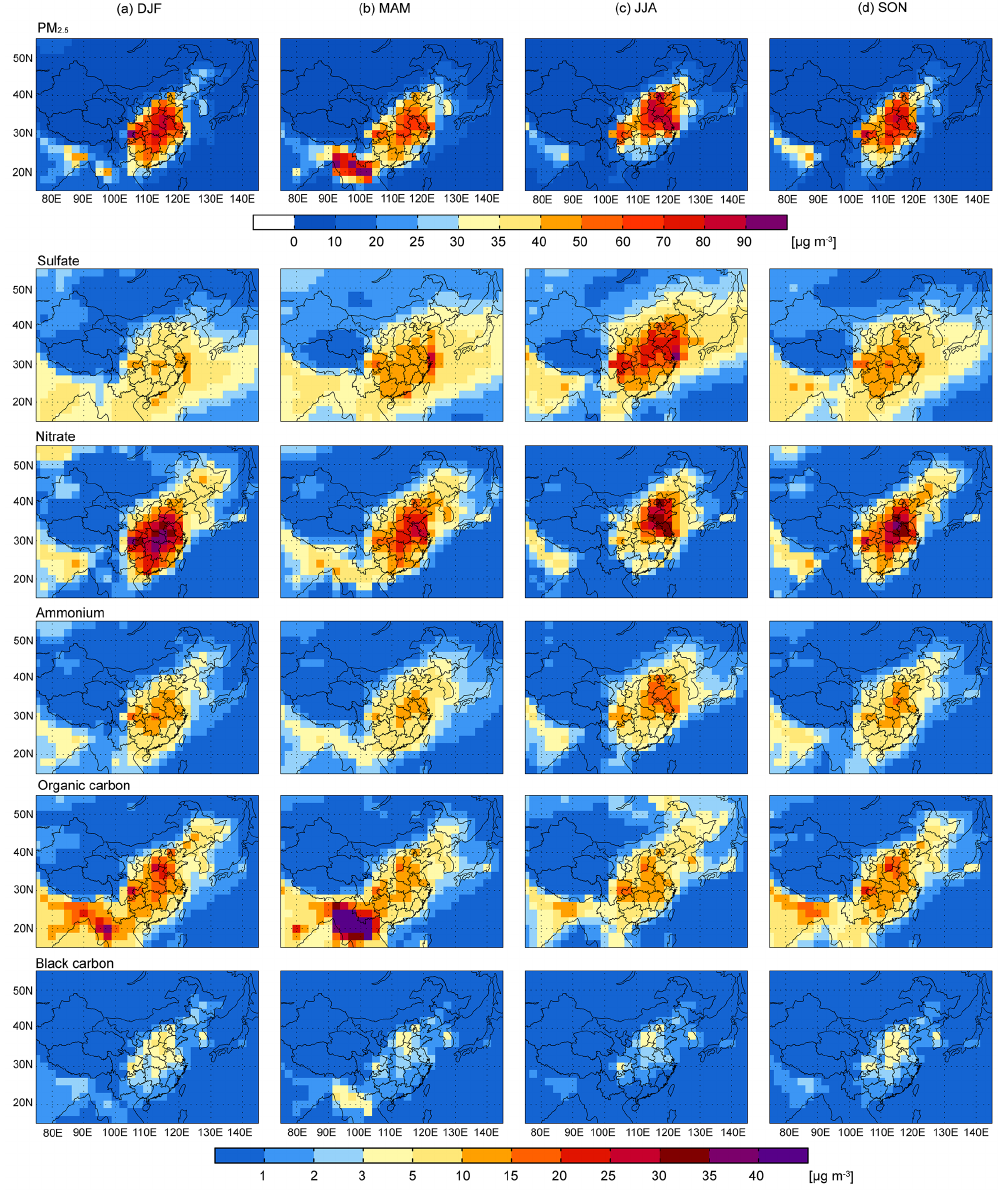
Figure 1. Seasonal mean surface concentrations of total PM 2 . 5 , sulfate (SO 2 − and black carbon (BC) in East Asia from the control ([ CTRL ]) simulation, averaged over